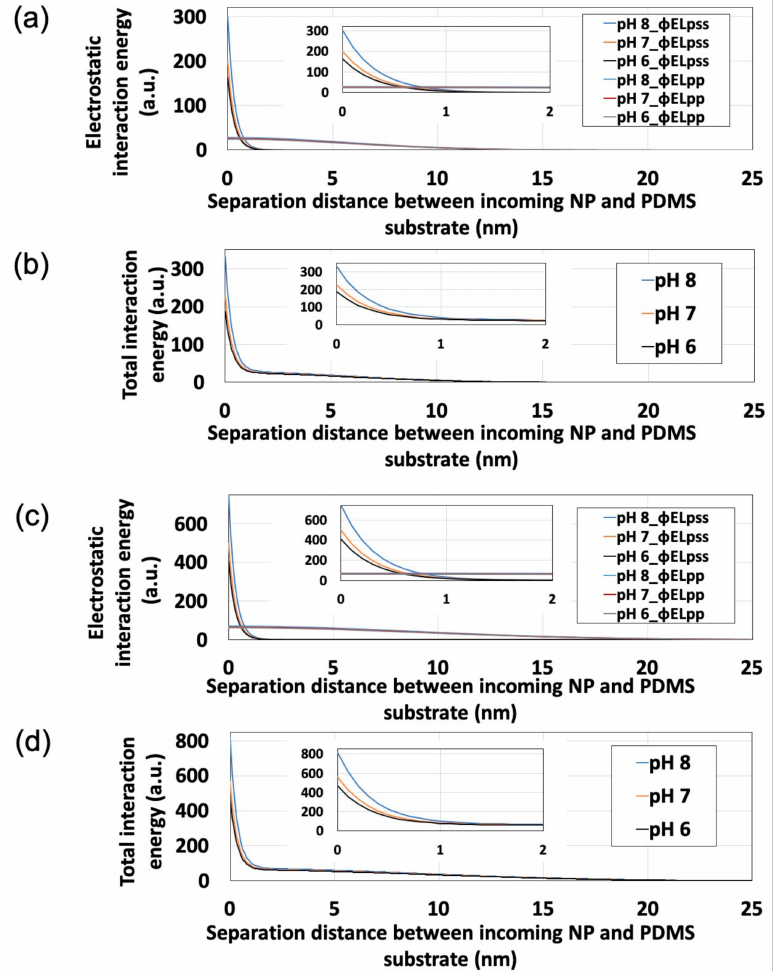
Figure 6. Effects of pH on interaction energy profiles obtained for polystyrene nanoparticles (NPs) approaching the polydimethylsiloxane-based substrate surface. Insets show the expanded origin regions. ( a ) φ EL pss and φ EL pp for 100-nm polystyrene NPs. ( b ) φ EL Total for 100-nm polystyrene NPs. ( c ) φ EL pss and φ EL pp for 250-nm polystyrene NPs. ( d ) φ EL Total for 250-nm polystyrene